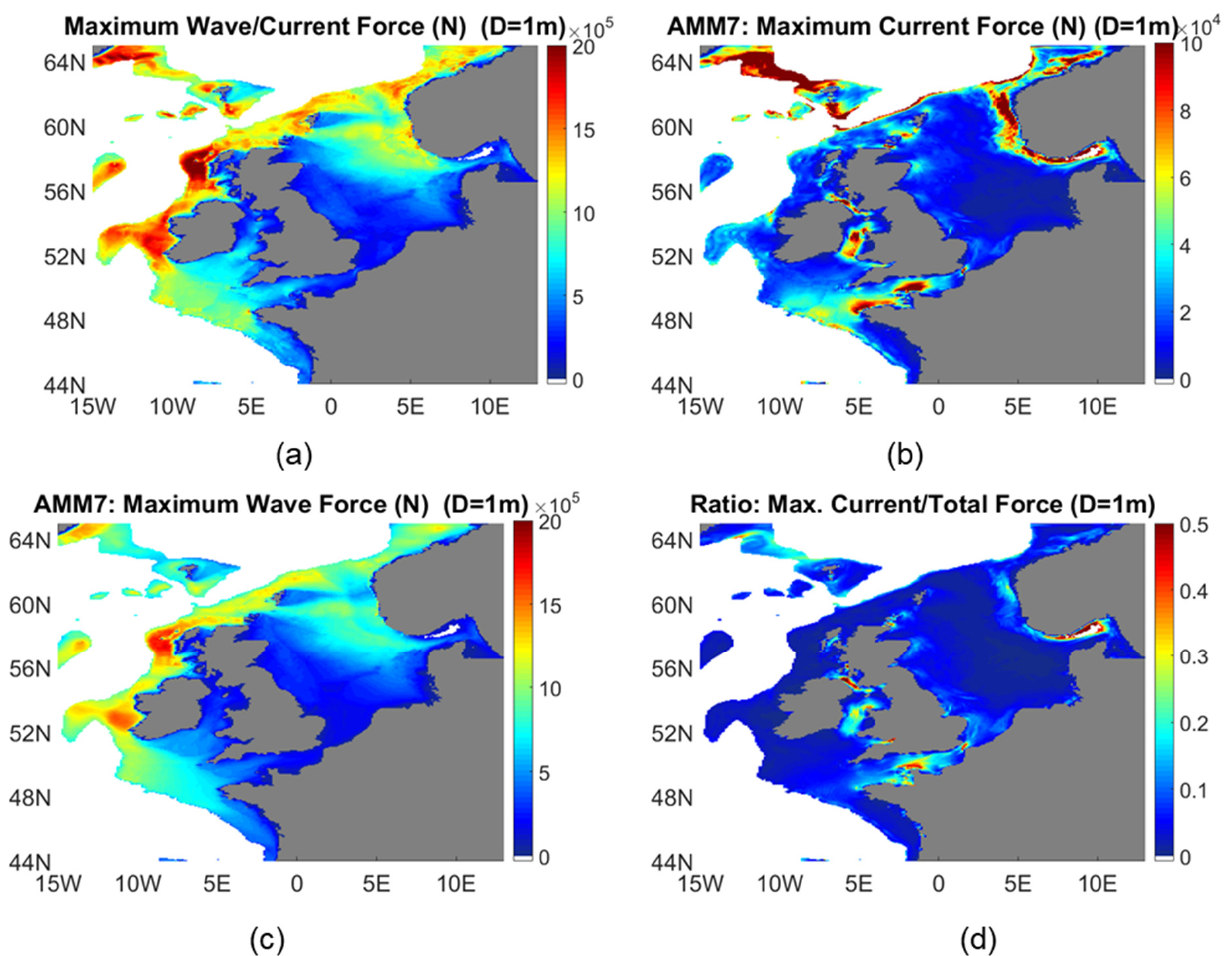
Figure 4. Spatial maps of maximum wave/current force ( a ), wave force ( b ), current force ( c ), and ratio of current contribution to total force ( d ), on a pile of diameter D = 1 m, deployment depth up to 500 m, from Met Office FOAM and WaveWatch III model outputs on the AMM7 grid over period July 2014 to June 2016.